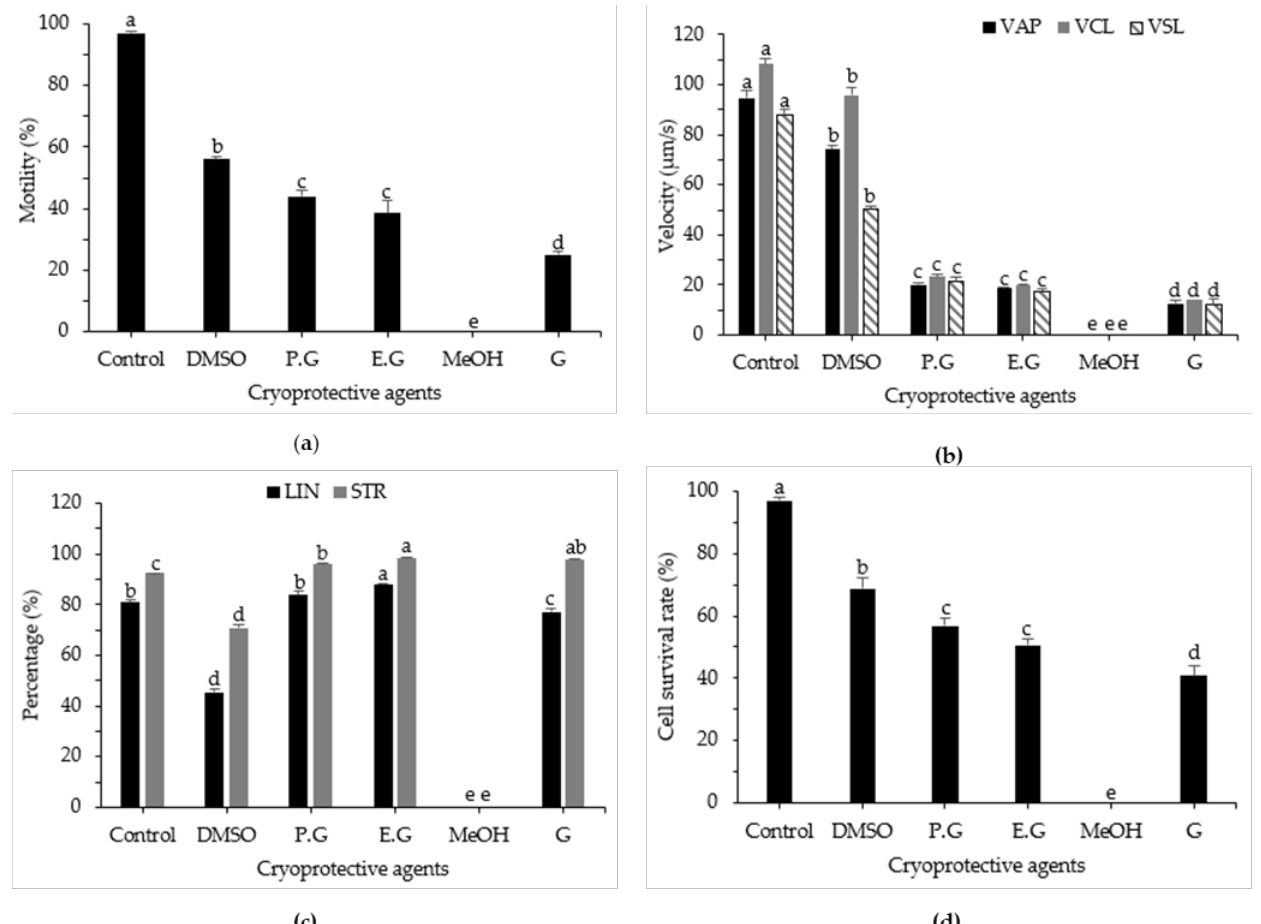
Figure 1. Computer-assisted sperm analysis of frozen and fresh sperm from roughscale sole, Clidoderma asperrimum , using various cryoprotective agents with 300 mM sucrose. ( a ) Motility (%), ( b ) average path velocity (VAP; µ m s − 1 ), curvilinear velocity (VCL; µ m s − 1 ), straight-line velocity (VSL; µ m s − 1 ), ( c ) linearity (LIN; %), straightness (STR; %), and ( d ) cell survival rate (%). Different lowercase letters indicate significant differences among cryoprotective agents ( p < 0.05). Control, fresh sperm; DMSO, dimethyl sulfoxide; EG, ethylene glycol; PG, propylene glycol; MeOH, methanol; G,